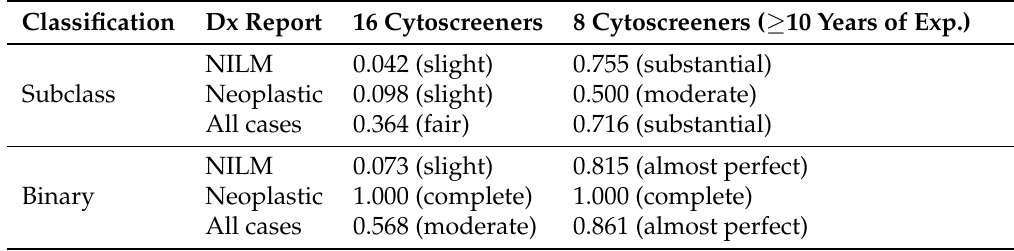
Table 5. Interobserver variability: